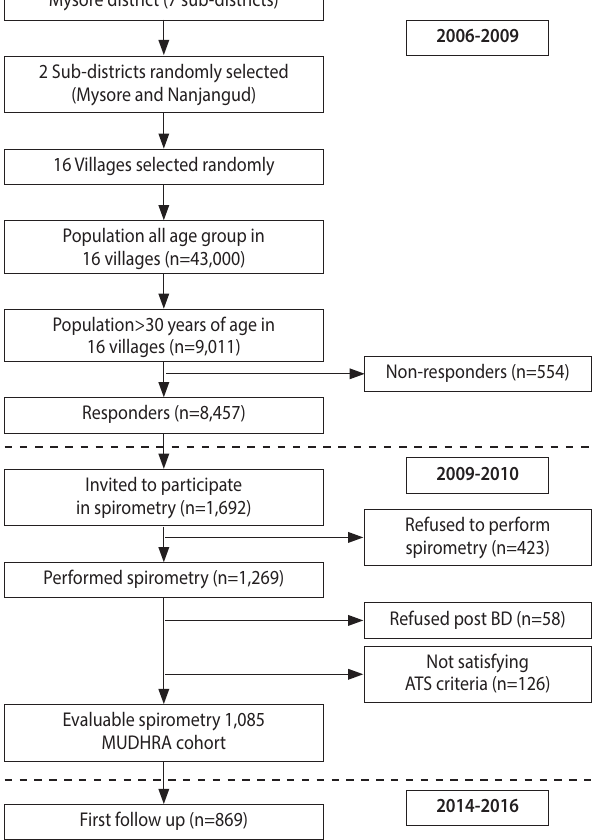
Figure 2. Flowchart for subject sampling and participation in differ- ent phases of the study. MUDHRA, Mysuru stUdies of Determinants of Health of Rural Adults; BD, broncho-dilator; ATS, American Tho- racic Society.